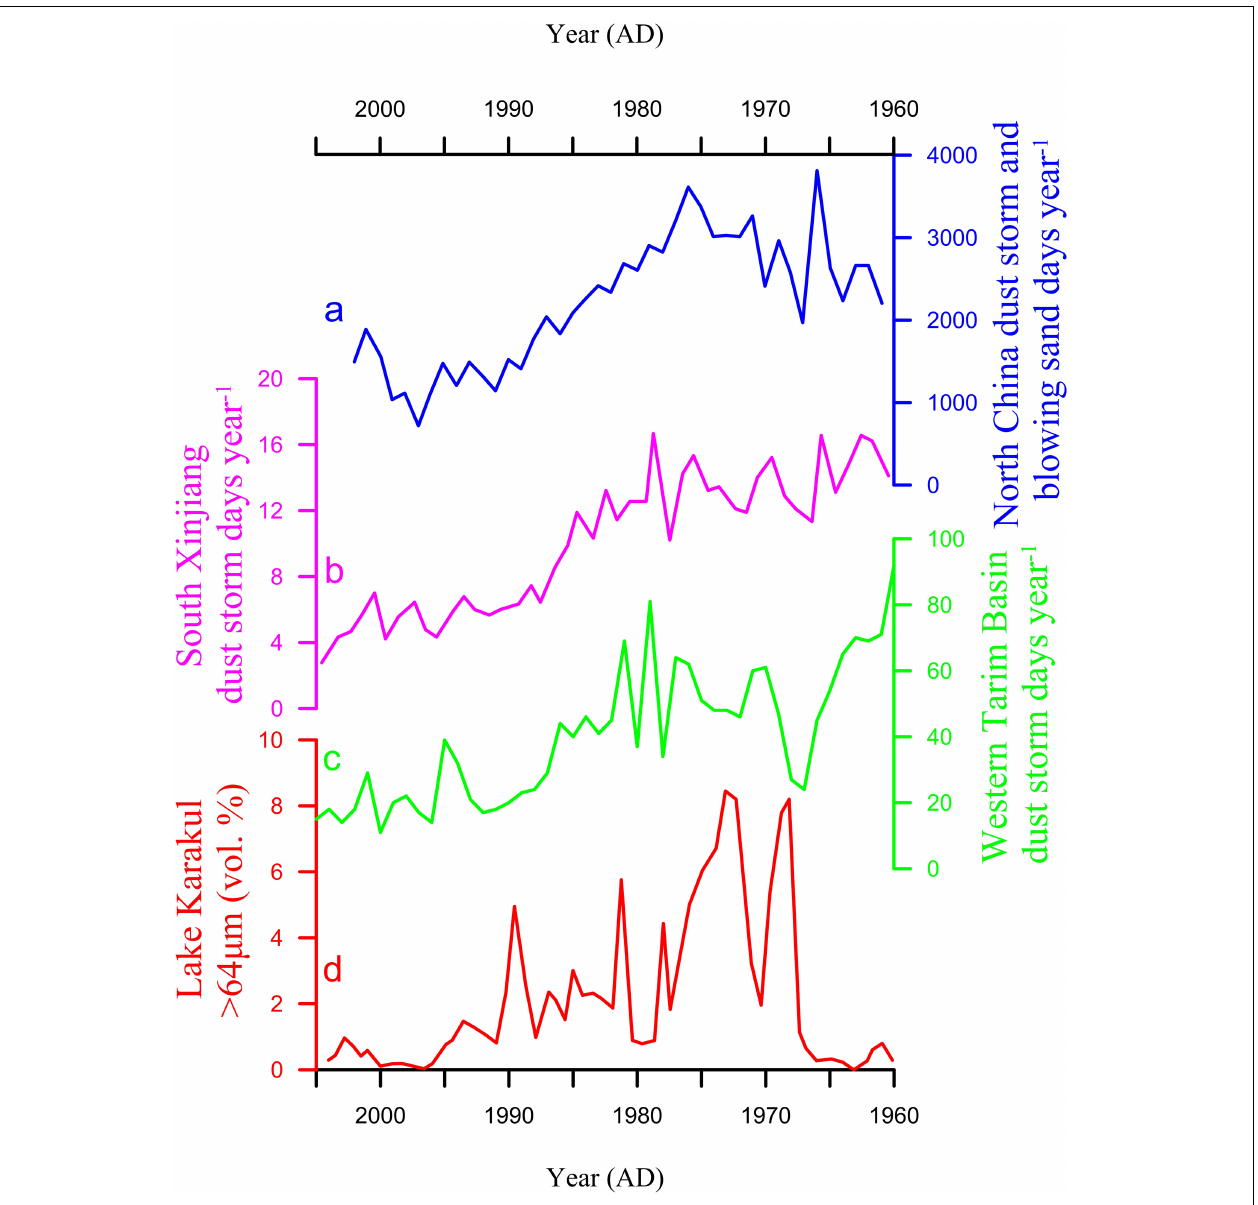
FIGURE 3 | Comparison of the volume percentage of the > 64 µ m fraction in Lake Karakul sediments (curve d, red, and this study) with observed dust storm days in arid northwest China (curve a–c). Curve a (blue) accumulated dust storm and blowing sand days at 175 stations in north China from 1962 to 2002 AD (Zhou et al., 2006). Curve b (pink) averaged dust storm days of 38 stations in south Xinjiang from 1961 to 2005 AD (Li et al., 2008). Curve c (green) dust storm days at 7 stations in western Tarim Basin from 1960 to 2005 AD (the dust storm time series of each station are provided in Supplementary Figure S4